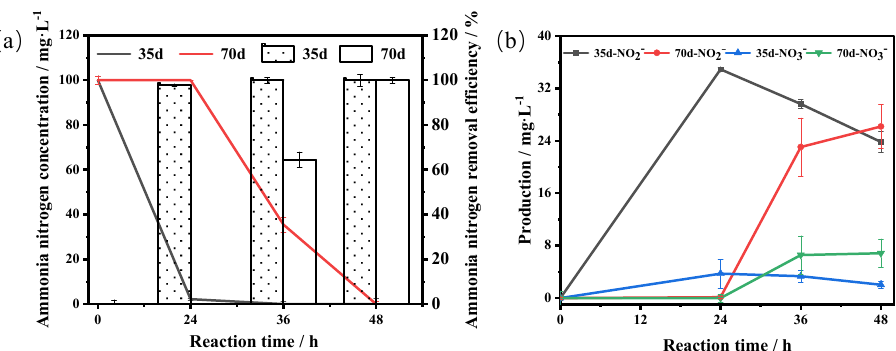
Figure 5. Storage stability of immobilized cells stored at 4 °C. ( a ) Ammonia nitrogen concentration and ammonia nitrogen removal efficiency, ( b ) NO 2 − -N and NO 3 − -N production.